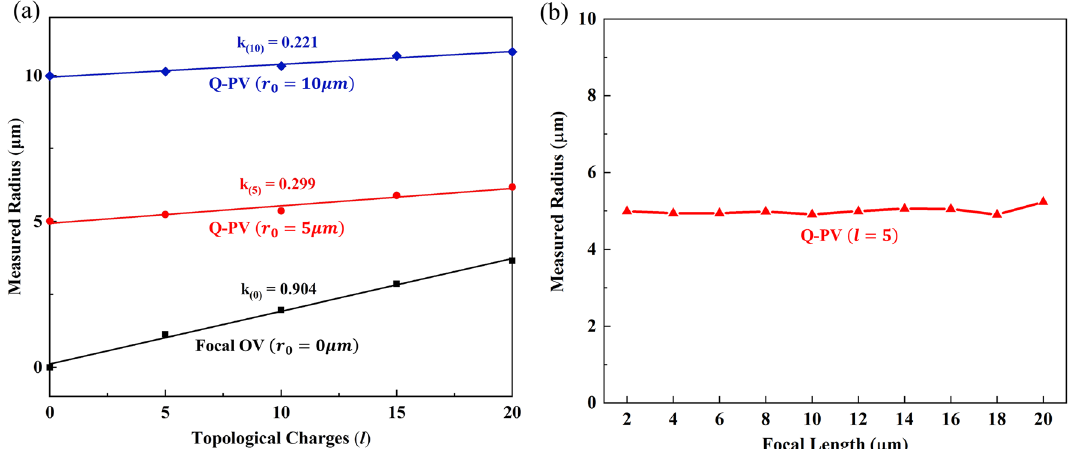
Figure 3. The radii of the Q-PV ring under different TCs and focal lengths. ( a ) The relationship between TC ( l = 0, 5, 10, 15, 20) and r . The dots were fitted by straight-line fit method. The slopes of fitting lines with TCs of 1,5 and 10 are k (0) , k (5) and k (10) , respectively. ( b ) The relationship between f and r when l equals to 5, r 0 equals to 5